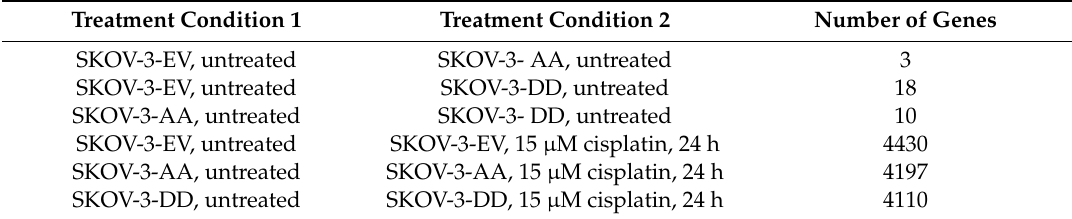
Table 1. Number of di ff erentially expressed genes, compared as treatment condition 1 vs. condition 2 with at least two-fold up- or down-regulation with p < 0.05.